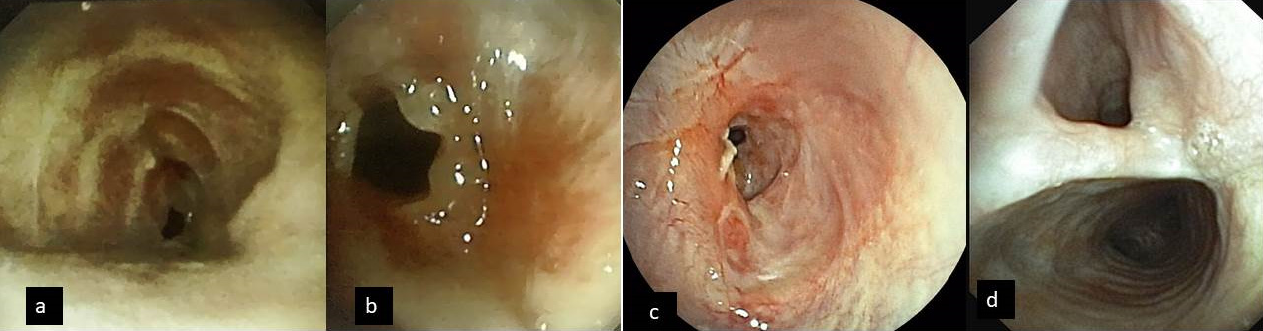
Figure 2. Bronchoscopic view of severe complex upper trachea stenosis ( a – c ) and tracheoesopha- geal fistula ( d ). fistula ( d